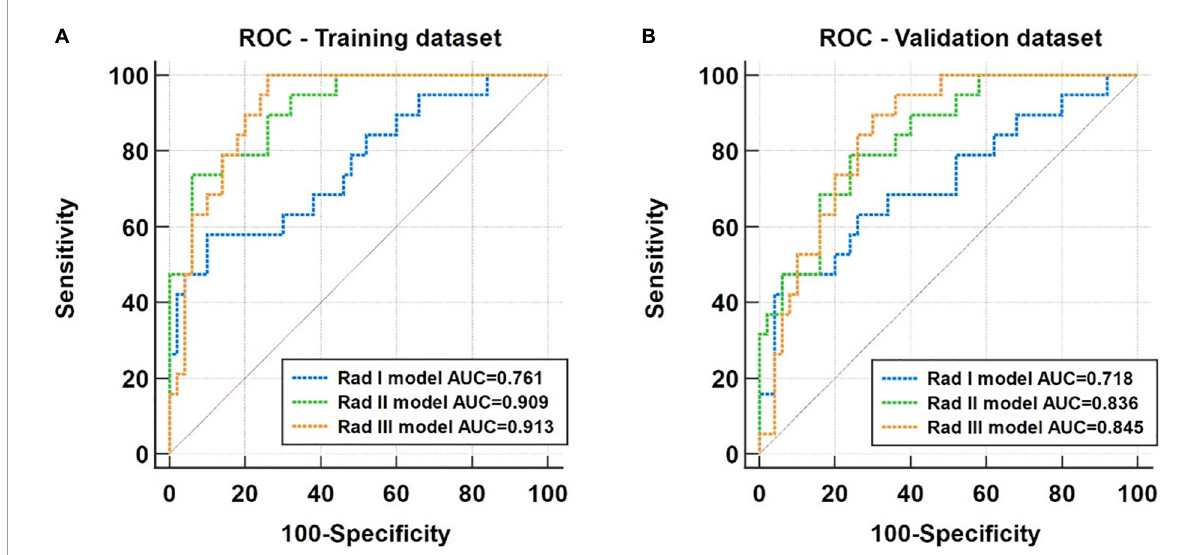
FIGURE5 Receiver operating characteristic (ROC) analysis for performance comparison of the Rad I (basal level), Rad II (middle level), and Rad III (apical) models in the training dataset (A) and the validation dataset (B) .